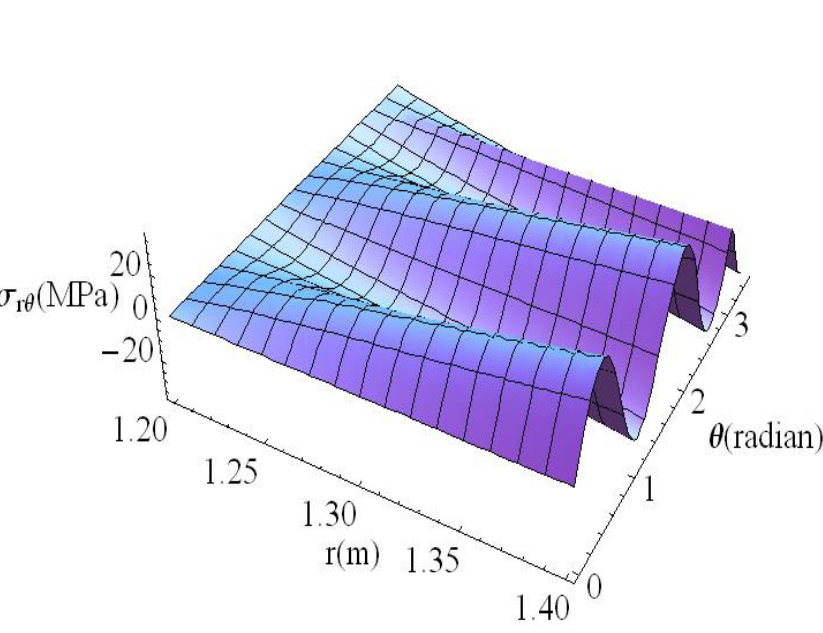
Figure 7. Shear stress at 𝛽 = 2